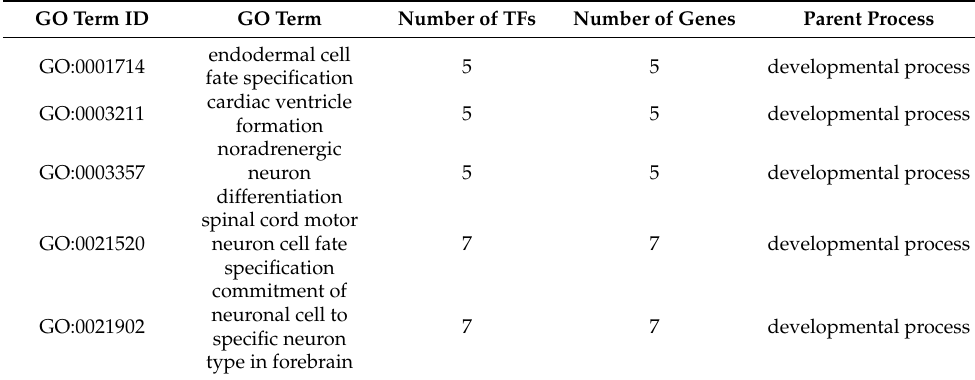
Table 2. Top 5 GO terms with the highest TF density.